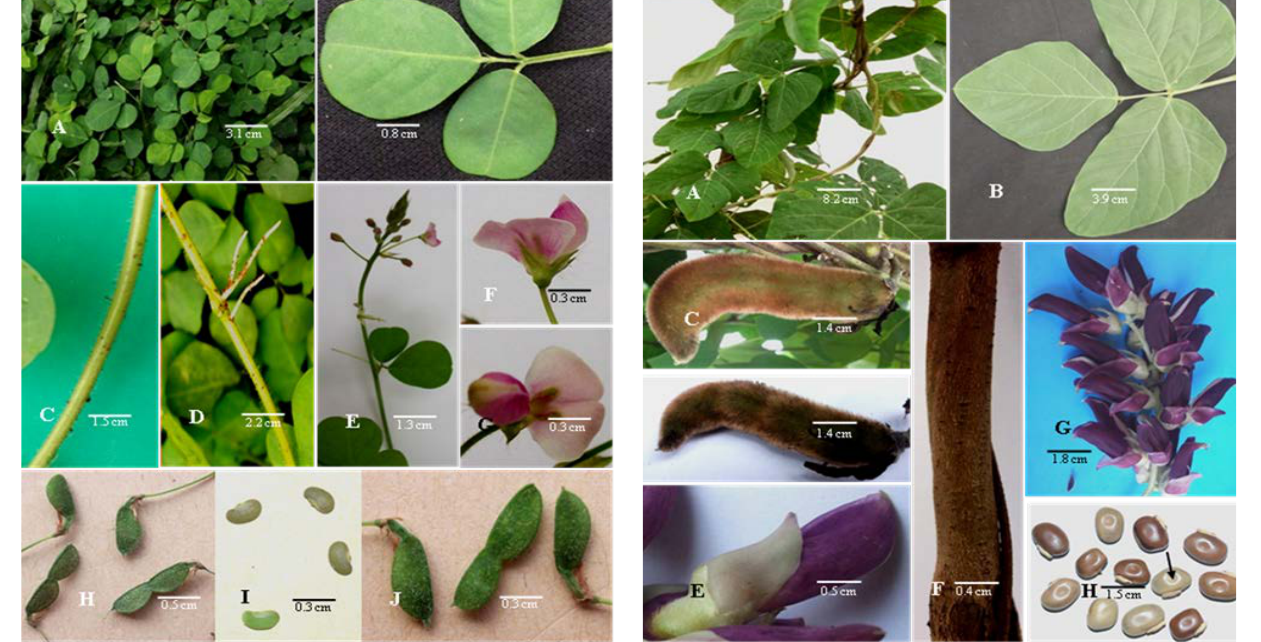
Fig. 4. Morphology of Mucuna pruriens (Linn.) Walp. Stem, G. Inflorescence, H. Seeds (arrow points at